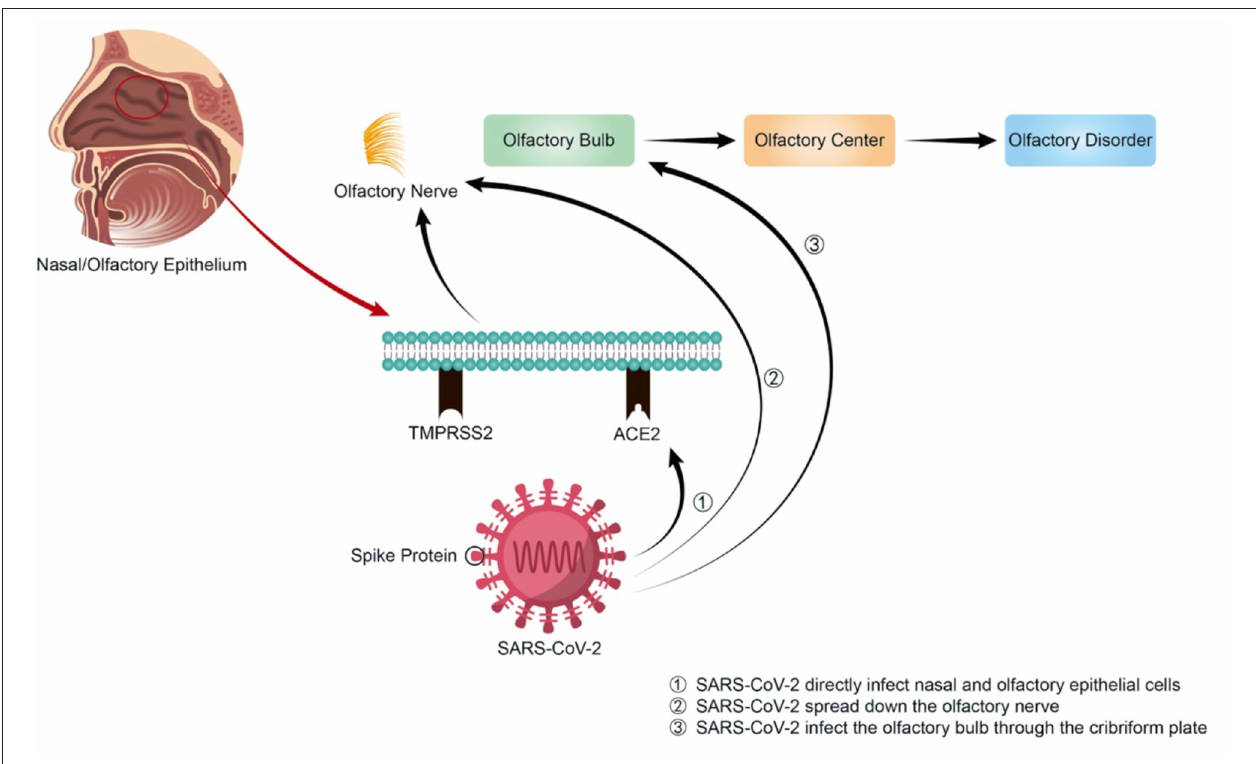
FIGURE 1 | Possible mechanisms of the olfactory dysfunction caused by